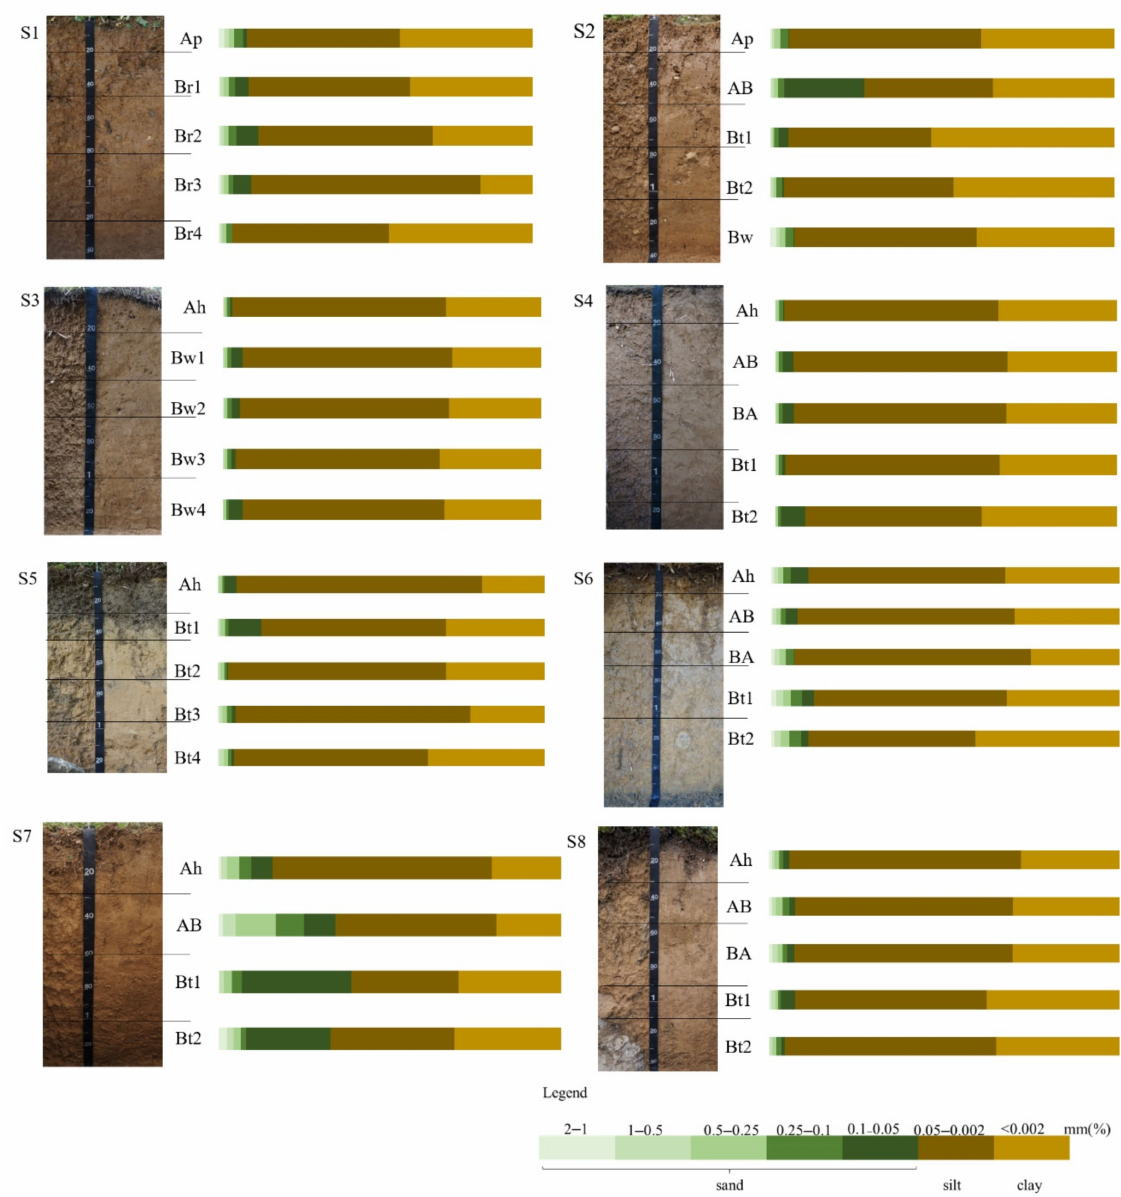
Figure 2. Depth plots of grain size distribution within soil